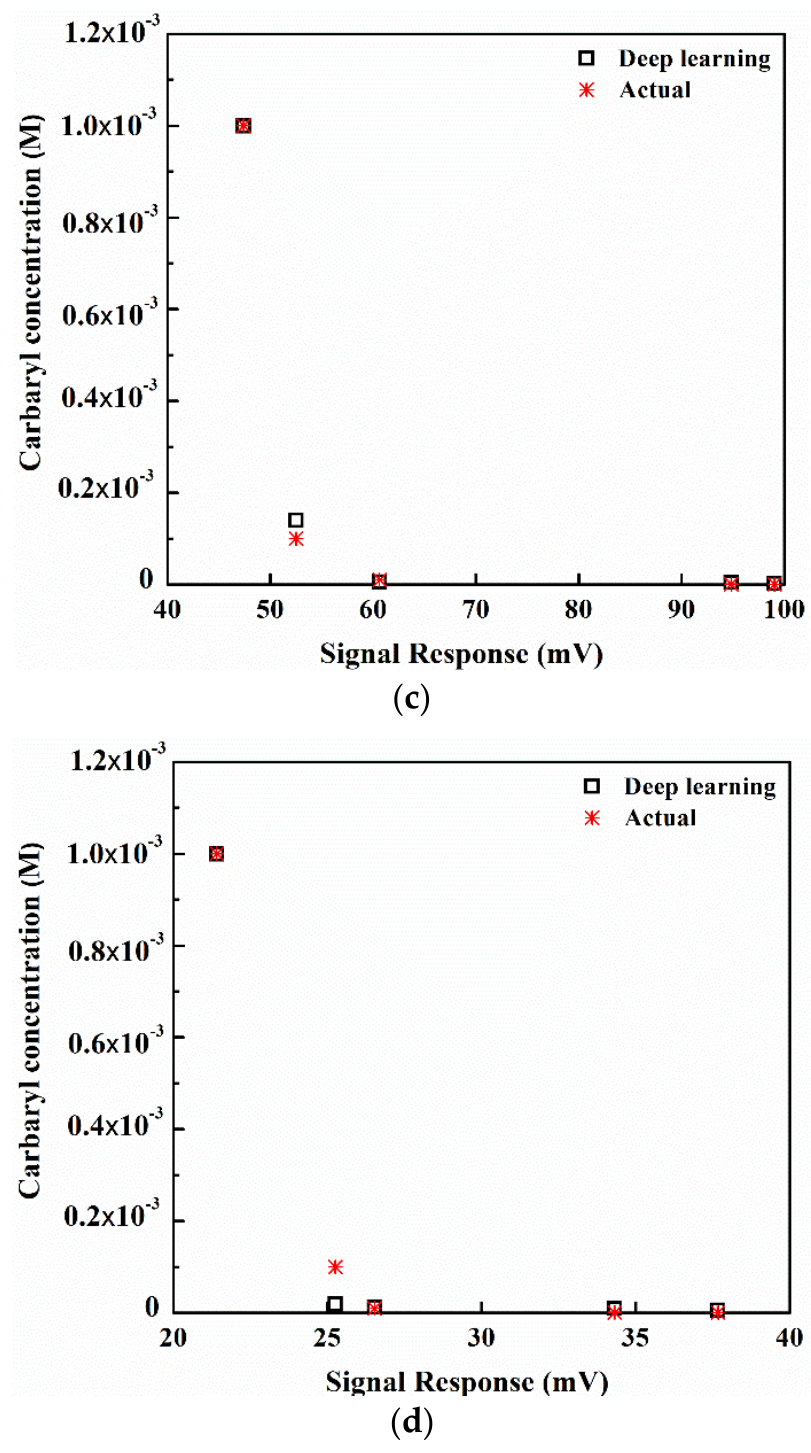
Figure 11. The actual and predicted concentrations of carbaryl in PBS using the multiple-input deep learning model at different temperatures of solutions given R 2 = 0.992: ( a ) 20 °C, ( b ) 25 °C, ( c ) 30 °C, and ( d ) 35 °C.